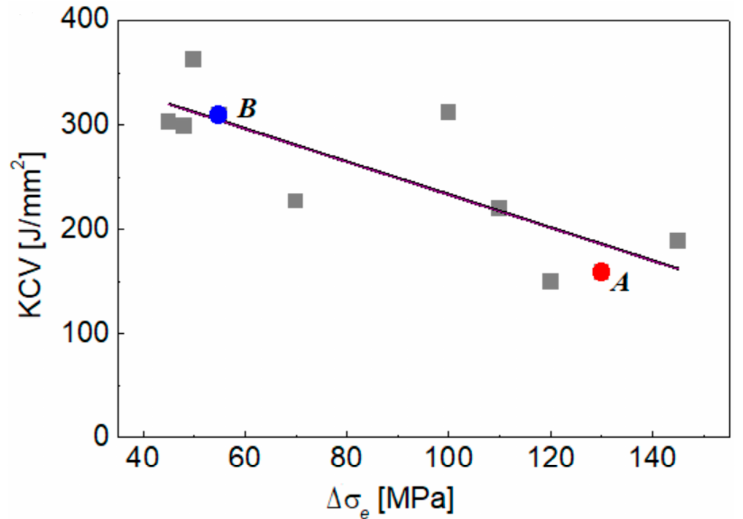
Figure 2. Dependence between impact toughness KCV and cyclic stress range Δσ e for steel cut out from various crane units. Units chosen for present research (A and B) are marked.